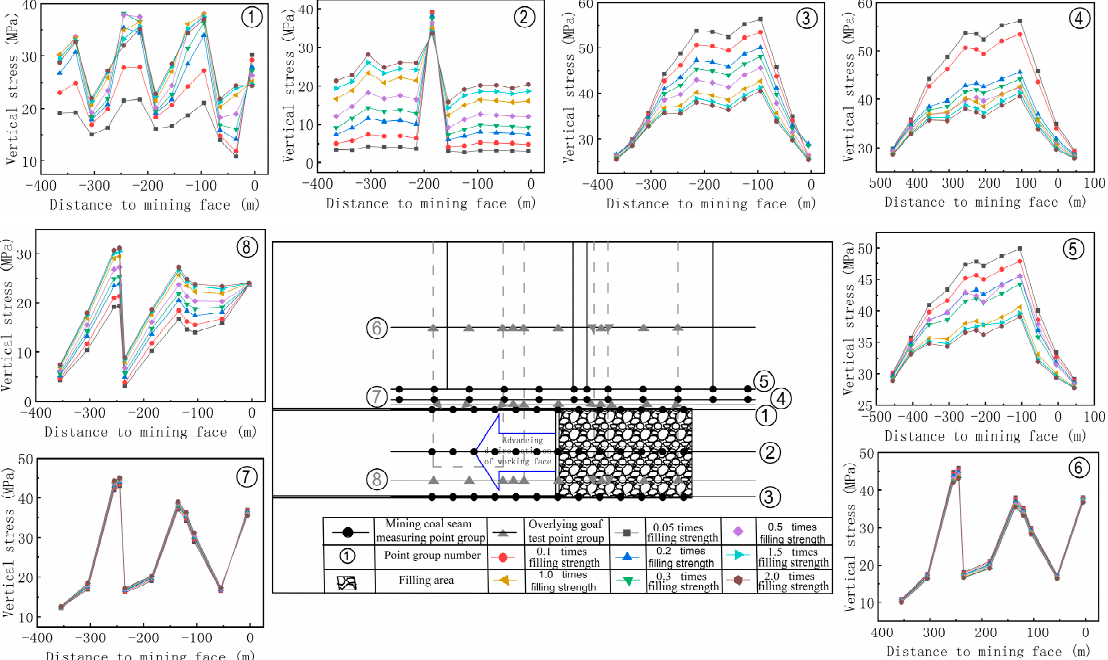
Figure 7. Distribution of the underground pressure.